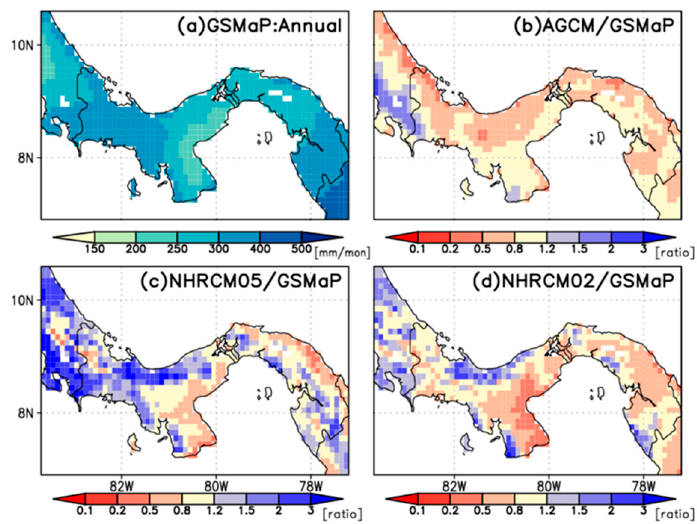
Figure 4. Same as in Figure 2 but for 20-year mean annual precipitation derived from ( a ) GSMaP v5, and biases in ( b ) MRI-AGCM, ( c ) NHRCM05, and ( d ) NHRCM02. Bias values are ratios of simulation to observation of GSMaP. See Table 4 for quantitative evaluation.